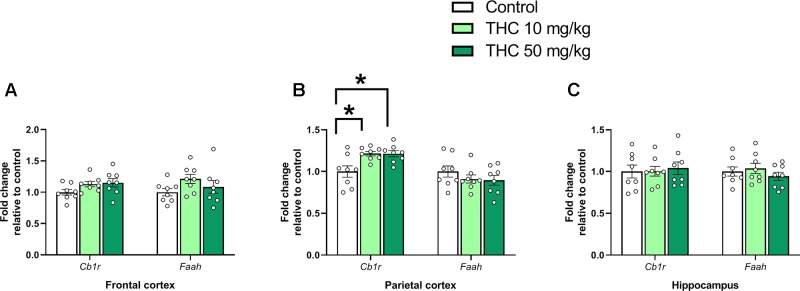
Endocannabinoid gene markers. Transcript levels of endocannabinoid genes Cb1r and Faah 24 h after PND 10 exposure to vehicle, 10 mg THC/kg or 50 mg THC/kg in the (A) frontal cortex, (B) parietal cortex, and (C) hippocampus. Statistical difference from post hoc test is indicated as * if p < 0.05 Height of bars represents the mean fold change ± SEM of 8 mice.